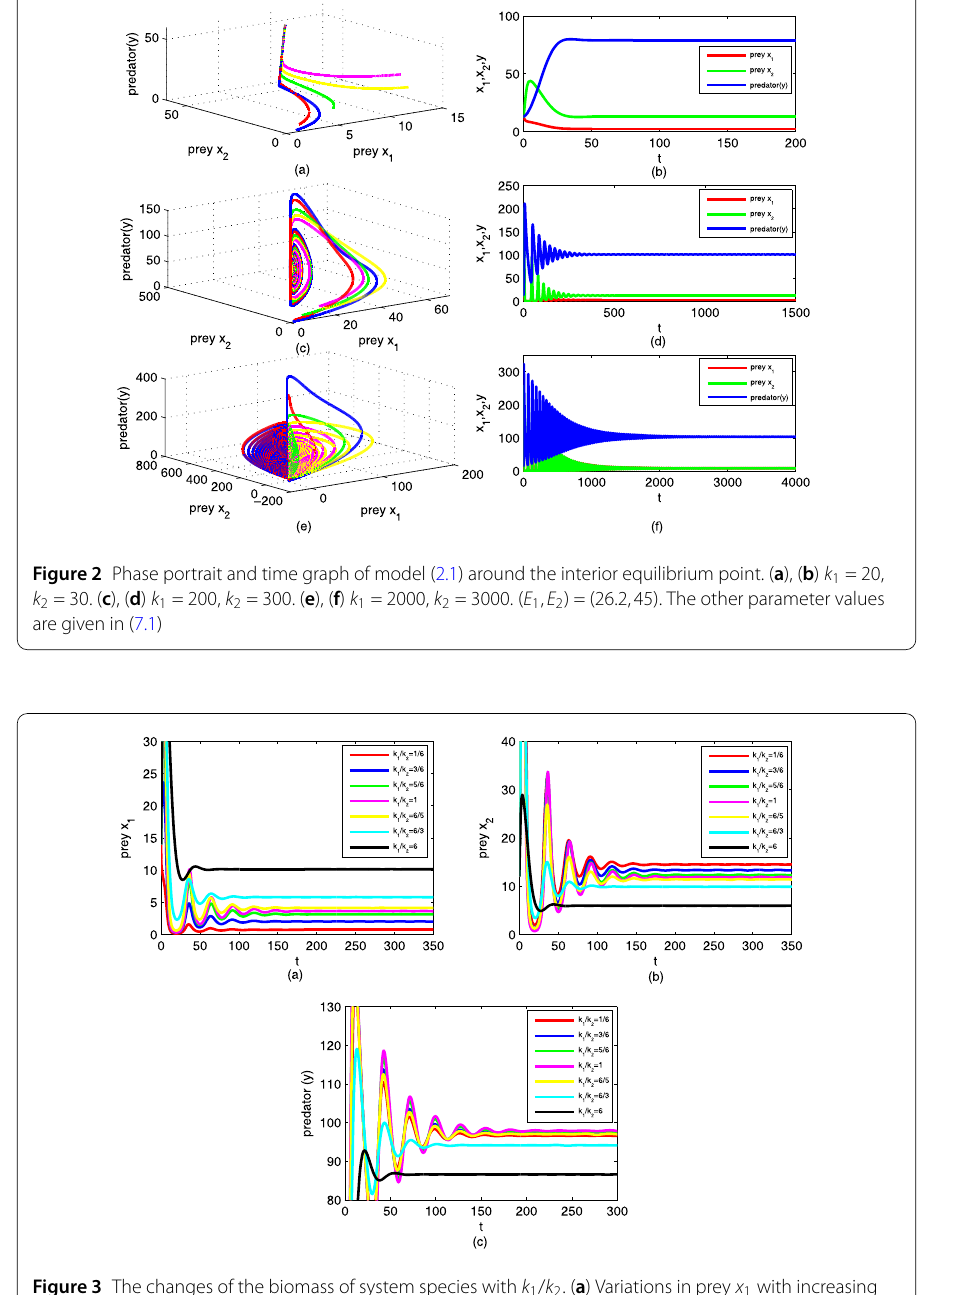
Figure 3 The changes of the biomass of system species with k 1 / k 2 . ( a ) Variations in prey x 1 with increasing time. ( b ) Variations in prey x 2 with increasing time. ( c ) Variations in predator ( y ) with increasing time. The parameter values are given in (7.1) and ( E 1 , E 2 ) =